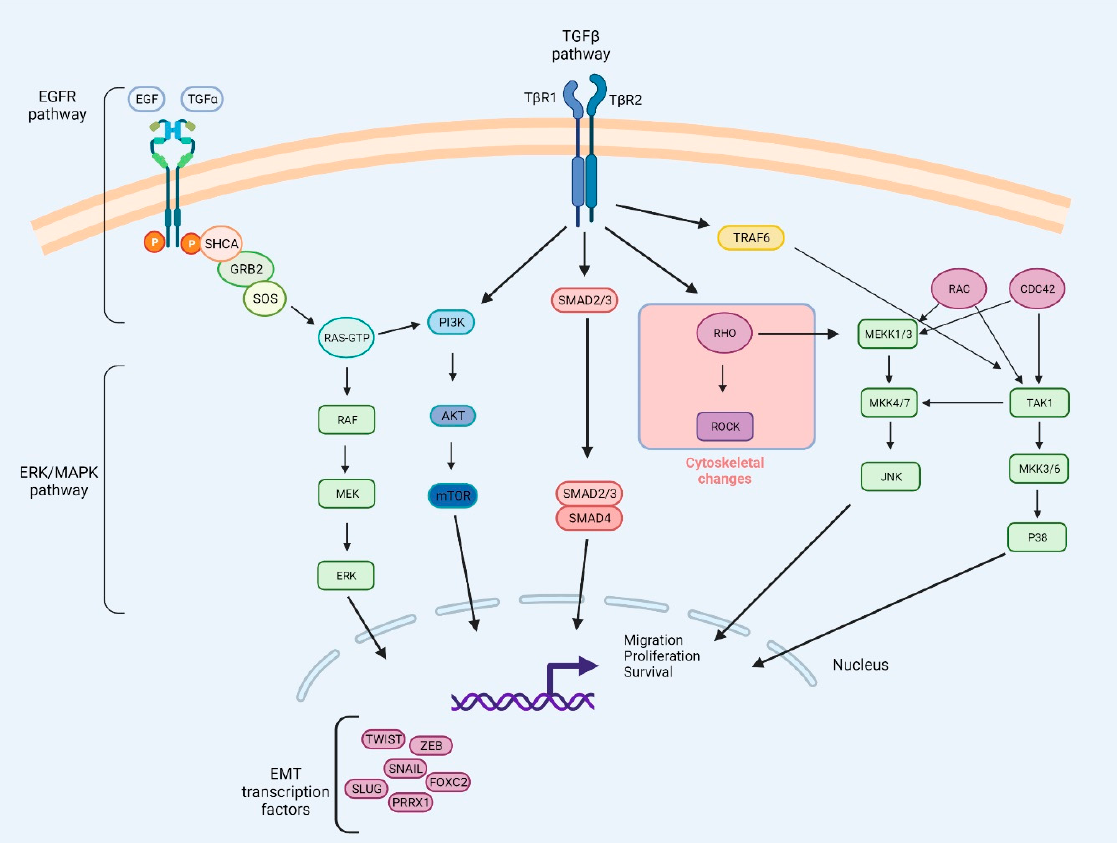
Figure 3. Integration network of epidermal growth factor receptor (EGFR), mitogen-activated